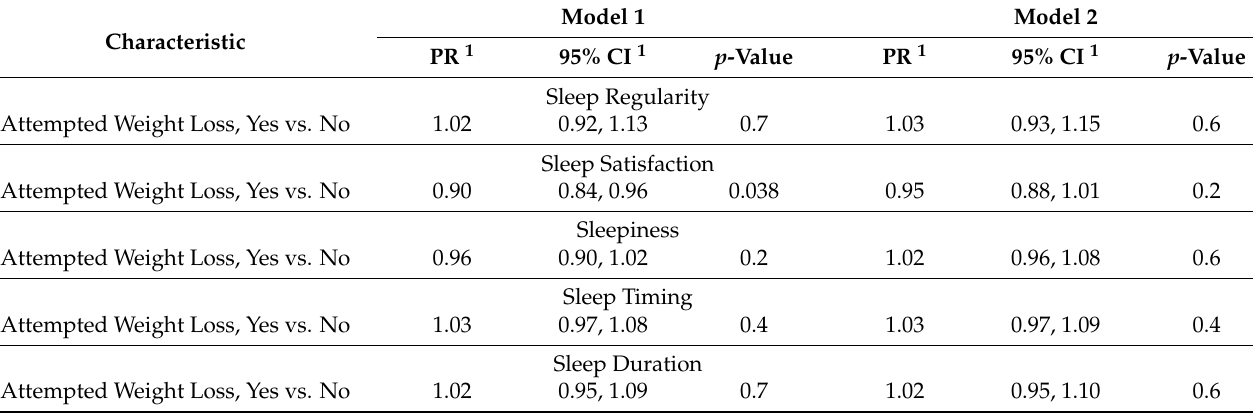
Table 3. Prevalence ratios for good sleep health indicators by weight loss attempt status.